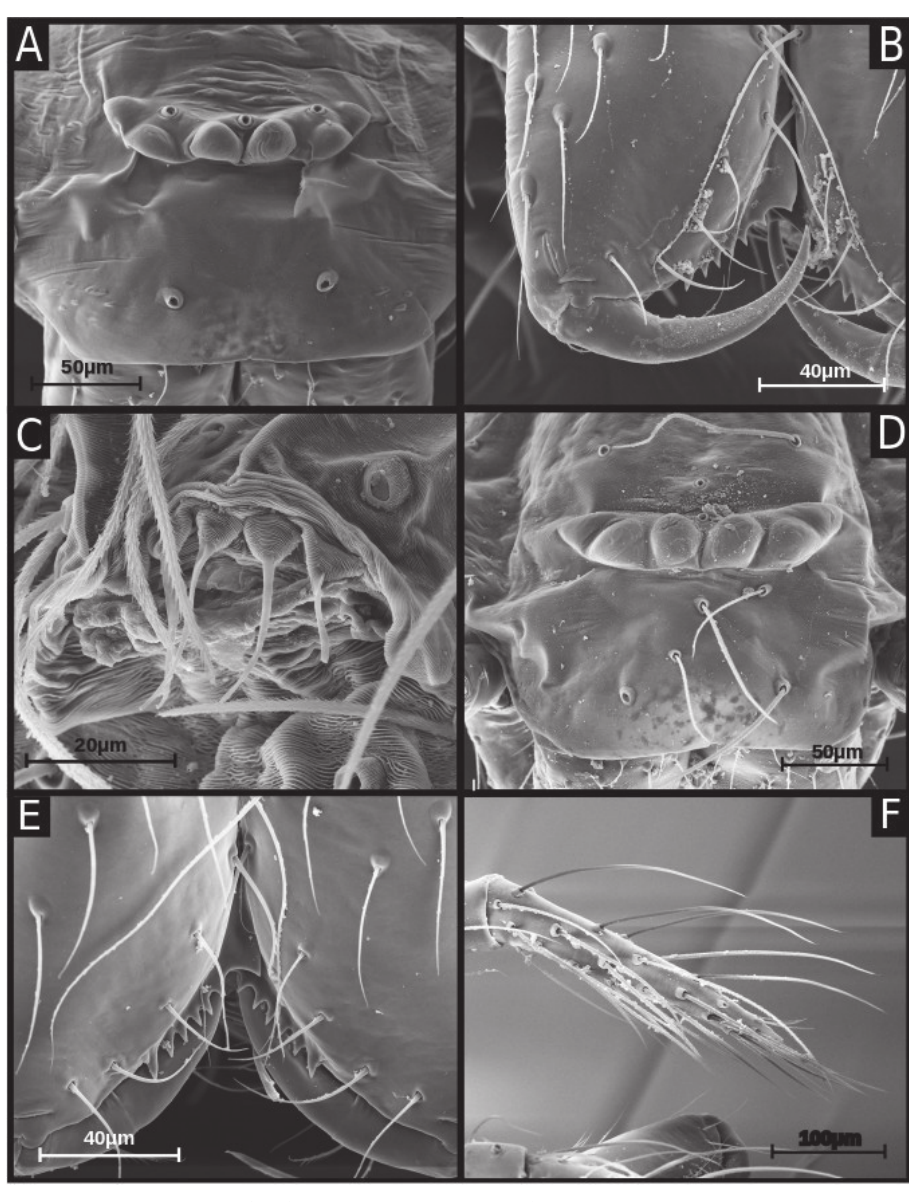
Figure 10. SEM images of Ochyrocera monica sp. nov., male (IBSP 196681) A carapace, anterior view B chelicerae, frontal view C epiandrous area, abdomen, ventral view D female (IBSP 196676), carapace, dorsal view E chelicerae, frontal view F pedipalp, prolateral